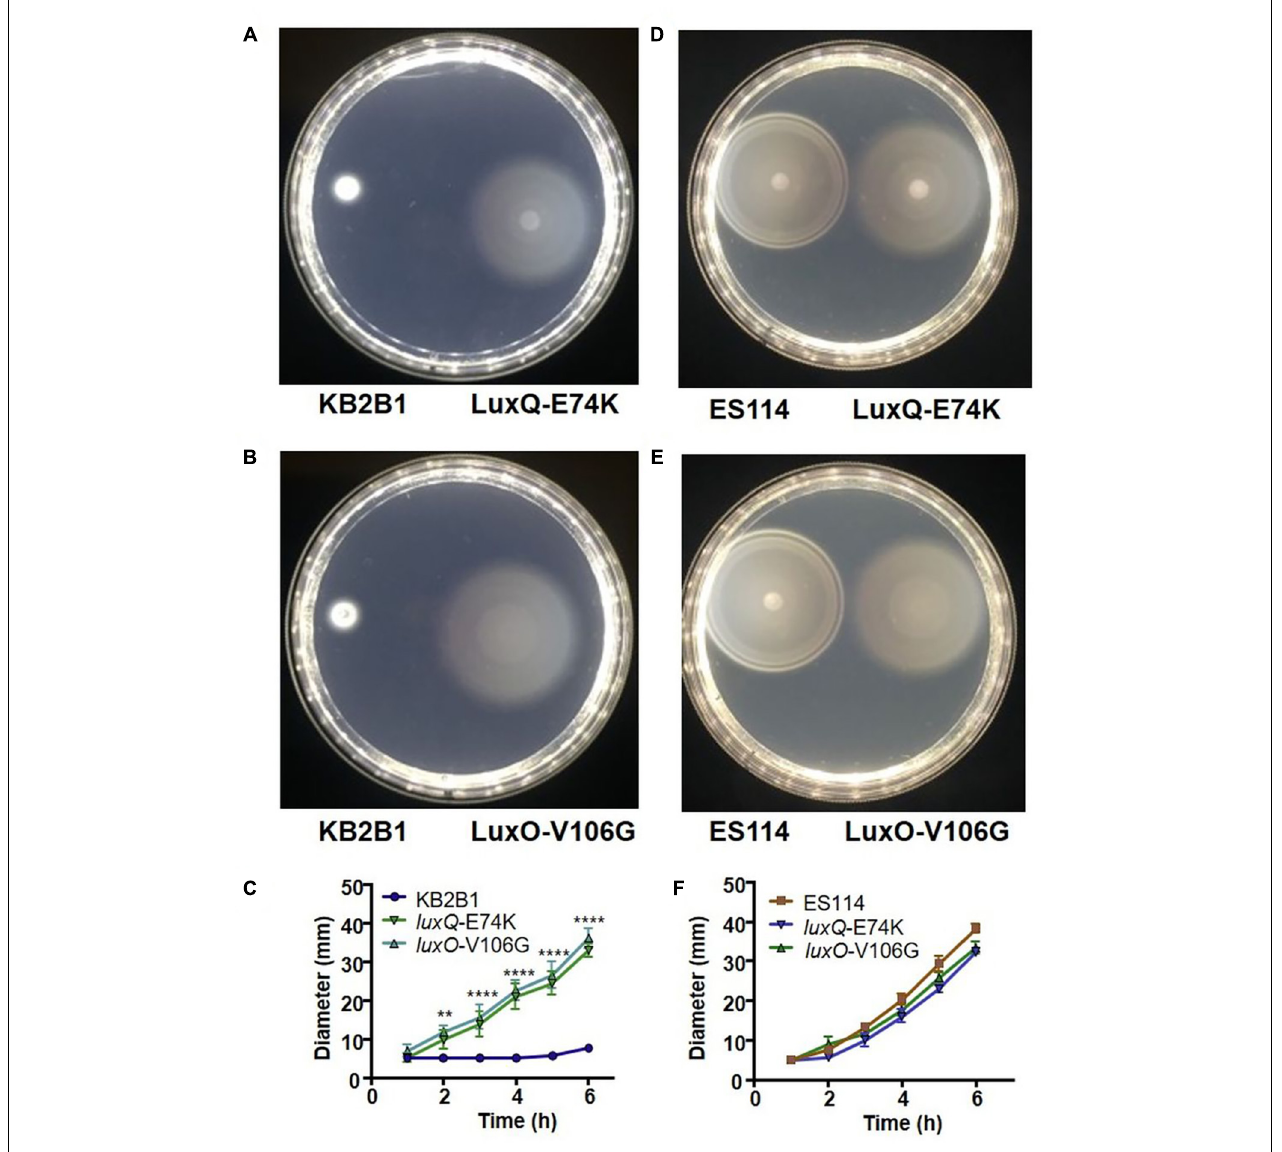
FIGURE 3 | Motility of KB2B1 point mutant suppressors. Motility on TBS-Mg 2 + agar of KB2B1 with motility suppressors (A) LuxQ-E74K (KV8961) and (B) LuxO-V106G (KV8964). Photos were taken 6 h after inoculation. (C) Measurements of the size of the diameter of the migrating strains (KB2B1, KV8961, and KV8964) over time. (D,E) Motility of the KB2B1 motility suppressor mutants LuxQ-E74K (D) and LuxO-V106G (E) compared with ES114. (F) Measurements of the size of the diameter of the migrating strains (ES114, KV8961, and KV8964) over time. Statistics were done using a two-way ANOVA. ** p = 0.002; **** p <